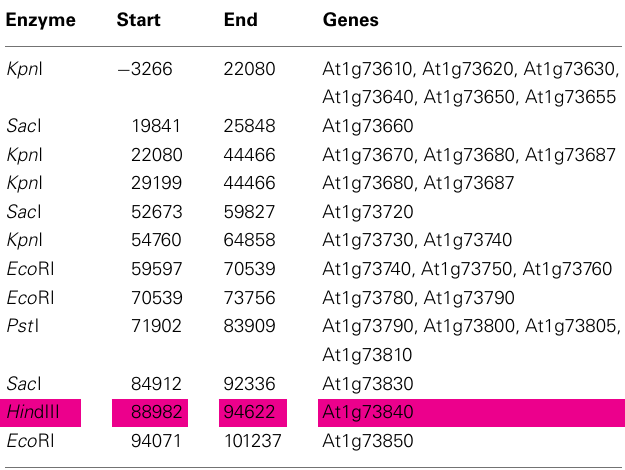
TableA2 | Sub-clones of BAC clone F25P22 used for complementation of rsr1-1 .